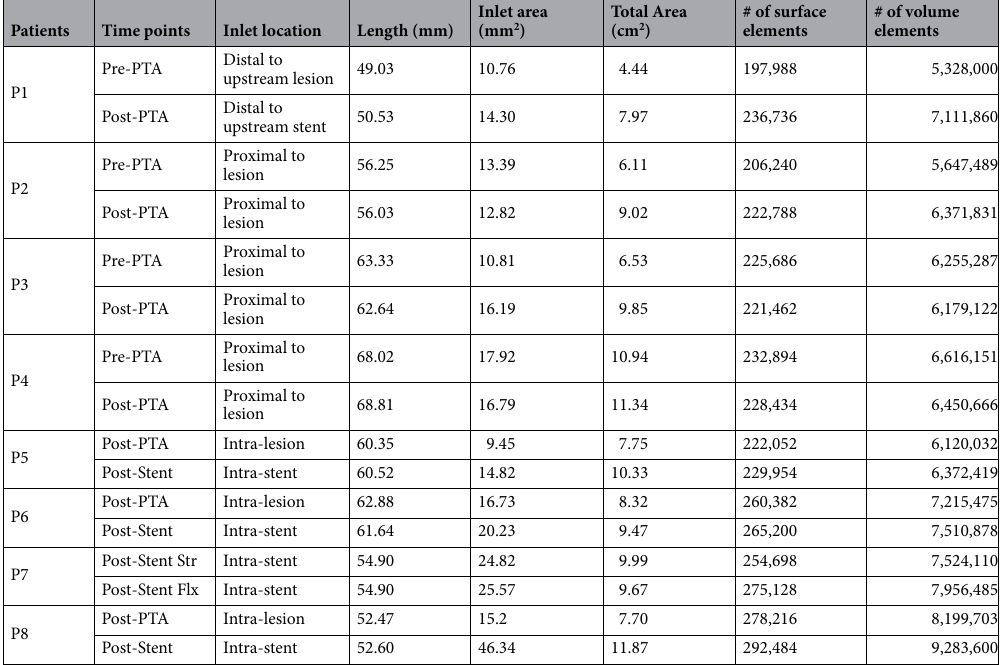
Table 2. The geometrical and FE mesh properties of the patient-specific arterial models reconstructed from OCT and X-ray images.